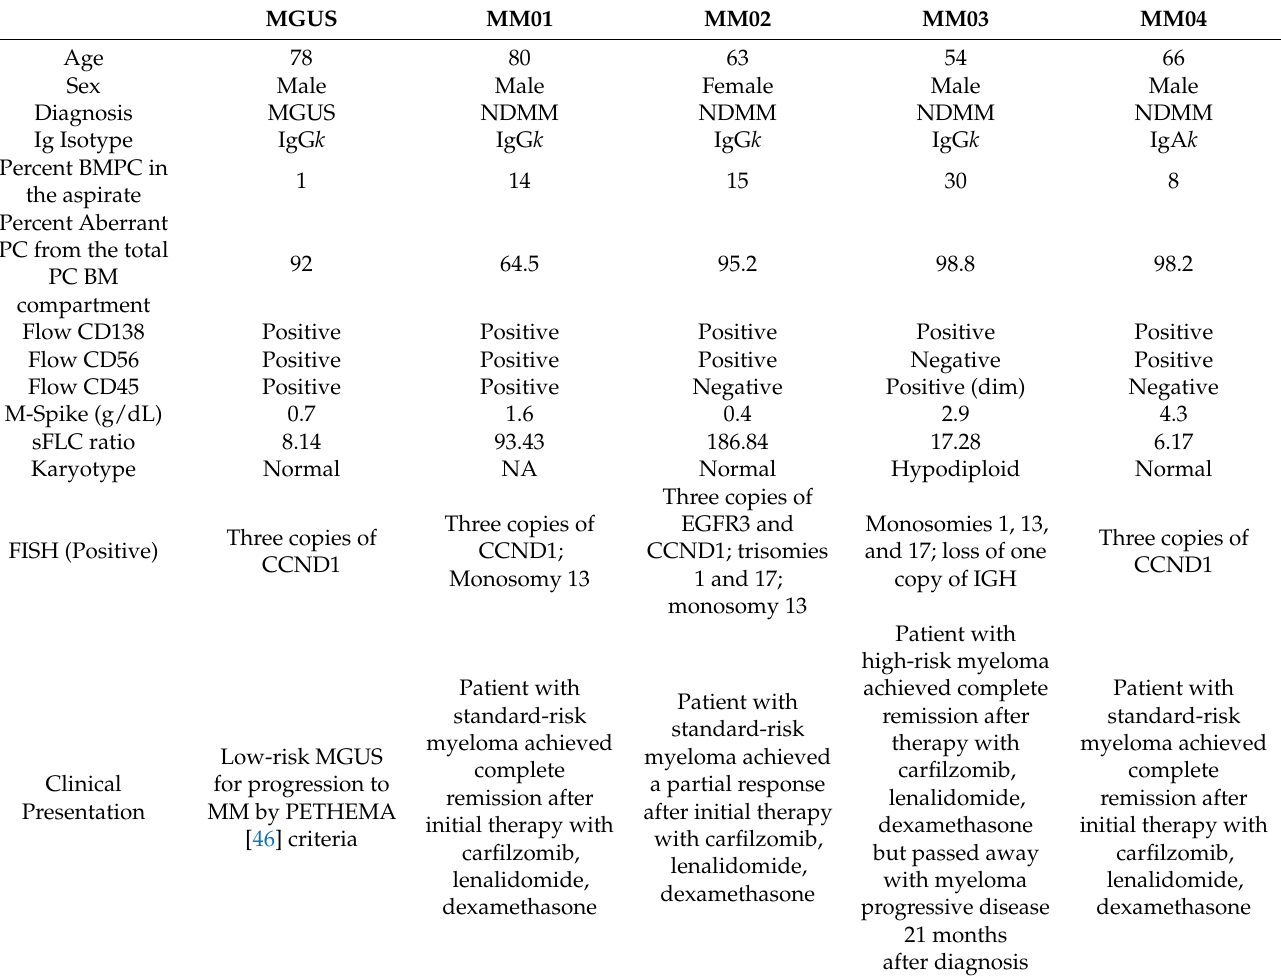
Table 1. Patient Demographics and Clinical